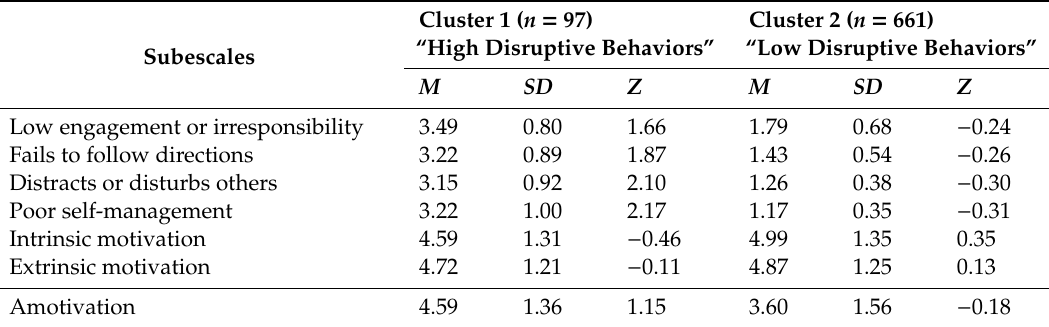
Table 3. Mean, standard deviation, and Z values in the clusters with the total sample.